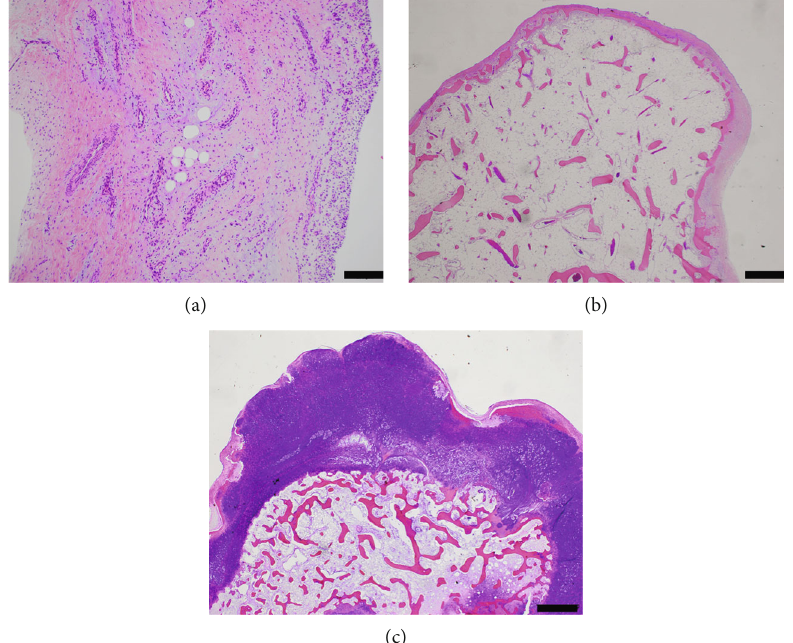
Figure 4: (a) Microscopic images of the synovium, (b) brown mass lesion, and (c) white mass lesion. No hyaline cartilage component was found in the synovium (a). The brown mass was trabecular bone covered by fi brous tissue (b). The white free bodies were thick cartilage cap with ossi fi cation, which resembled the epiphysis (c). Scale bar, 200 μ